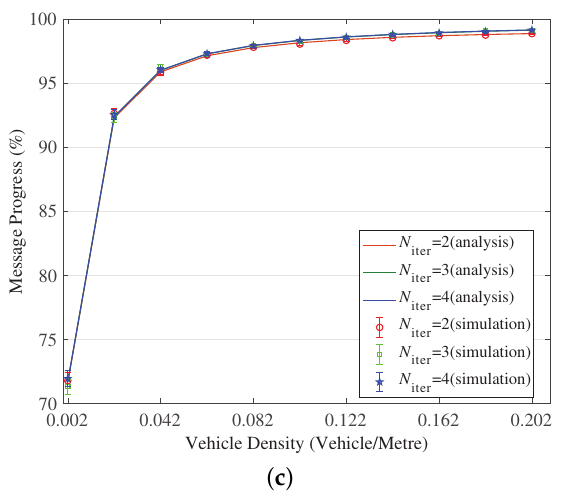
Figure 7. Validation of the model for message progress in Branch Phase. ( a ) When ( N iter , N part ) = ( 2,3 ) ; ( b ) When ( N iter , A ) = ( 2,2 ) ; ( c ) When ( N part , A ) = ( 4,2 ) .